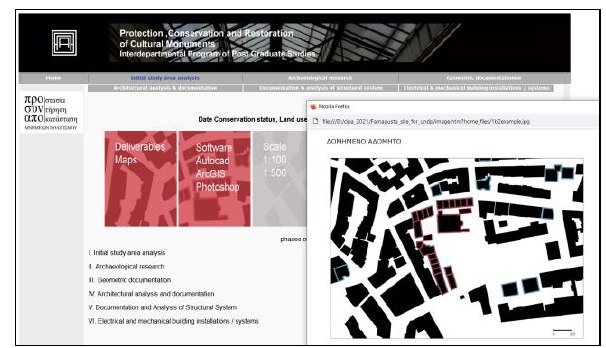
Figure 9 . Layout of the multimedia application (presentation of Initial study area analysis / Urban systems analysis / Date Conservation status, Land use, Structured / unstructured, Movements Heights / Example: Structured / unstructured areas).